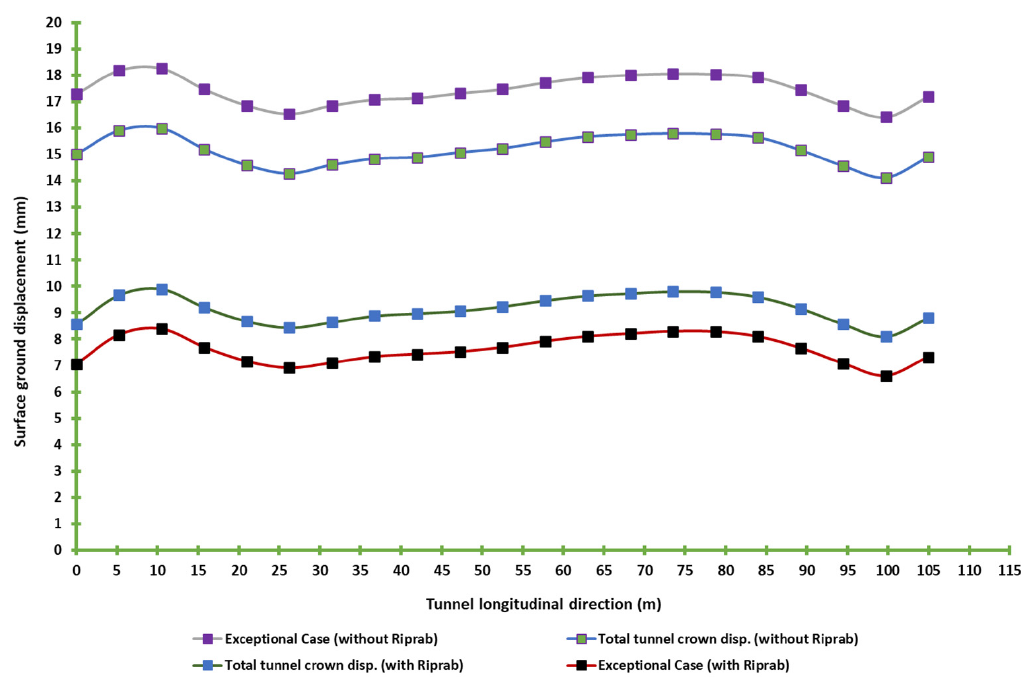
Figure 19. Displacement of surface ground during service stage. Figures 20 and 21 show the horizontal surface settlement displacement and transverse trough during the service stage during construction and service stages. The results show the effectiveness of riprap to reduce the tunnel crown displacement.